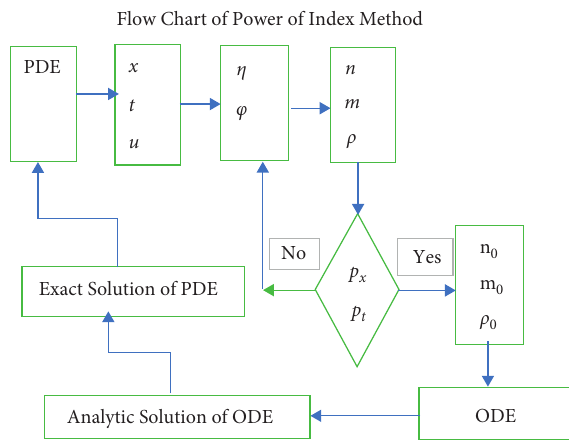
Figure 1: Flowchart of solution (7) of the